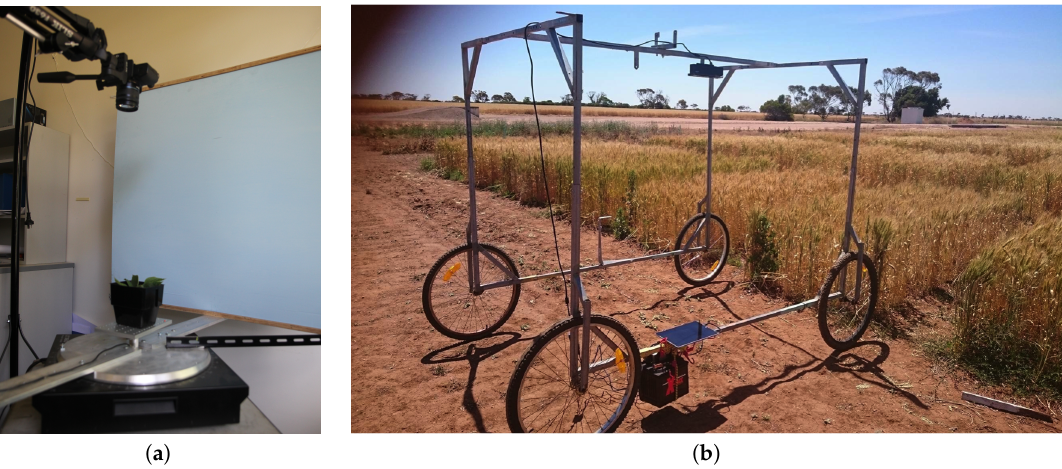
( a ) is the platform for imaging plants indoor and ( b ) is the platform for imaging outdoor plants growing in field